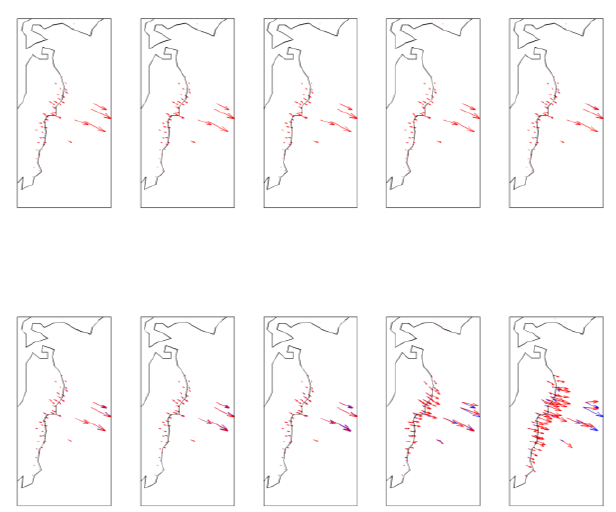
Figure 3: Inversion at time stamp at every 20